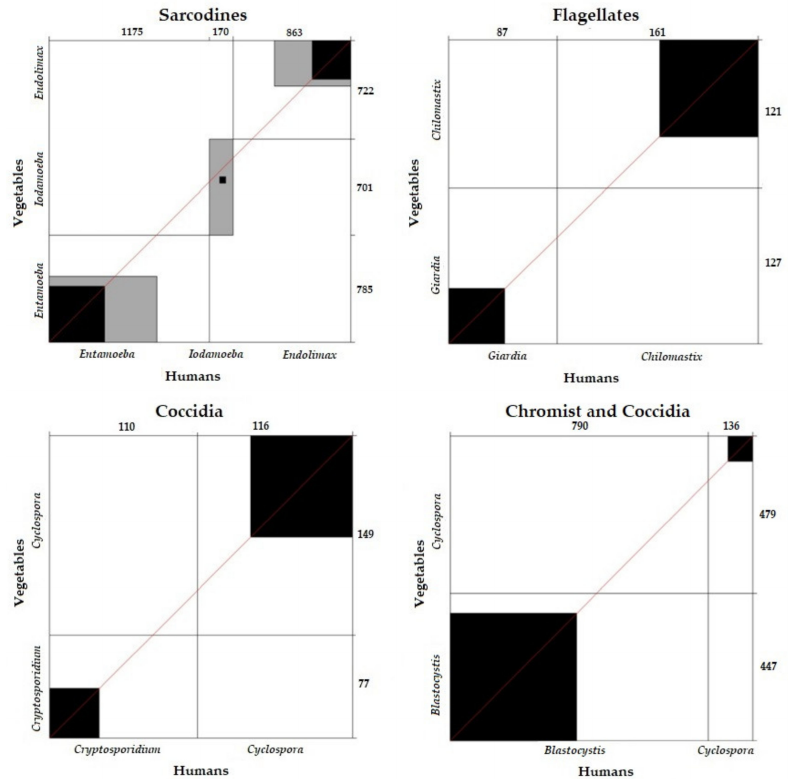
Figure 9. Concordance of parasite frequency between vegetables and humans according to parasite group.